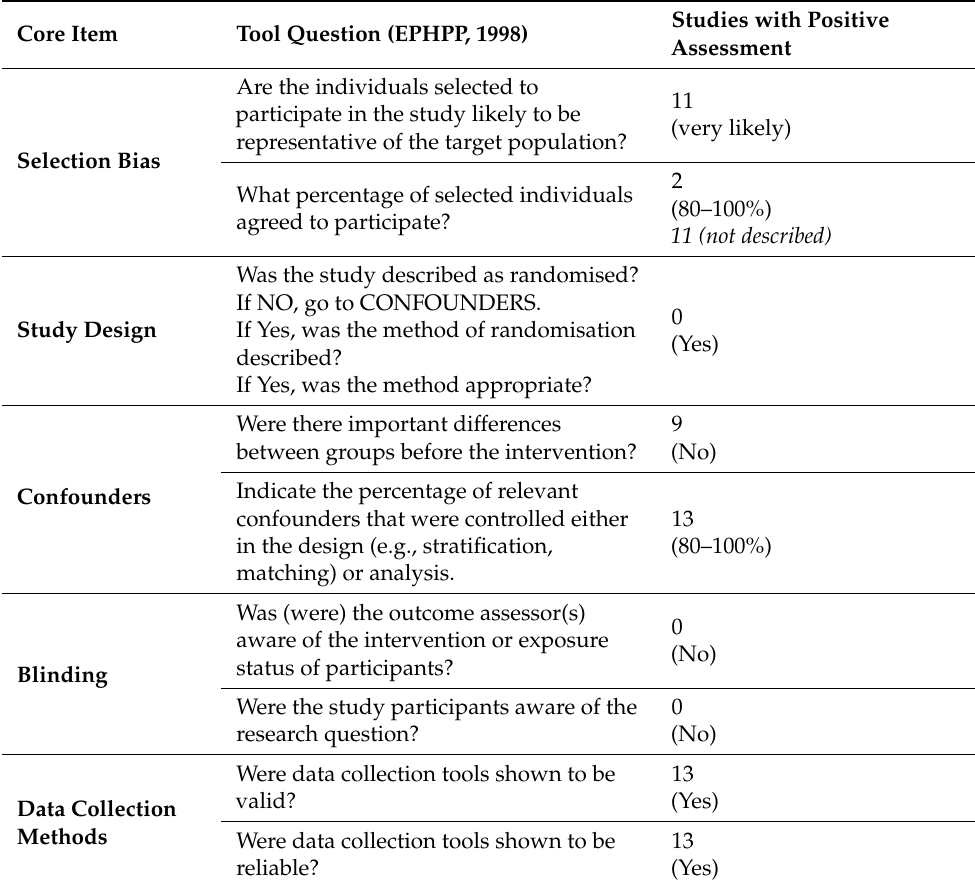
Table 2. Qualitative assessment results for quantitative studies included in the review ( n = 13).